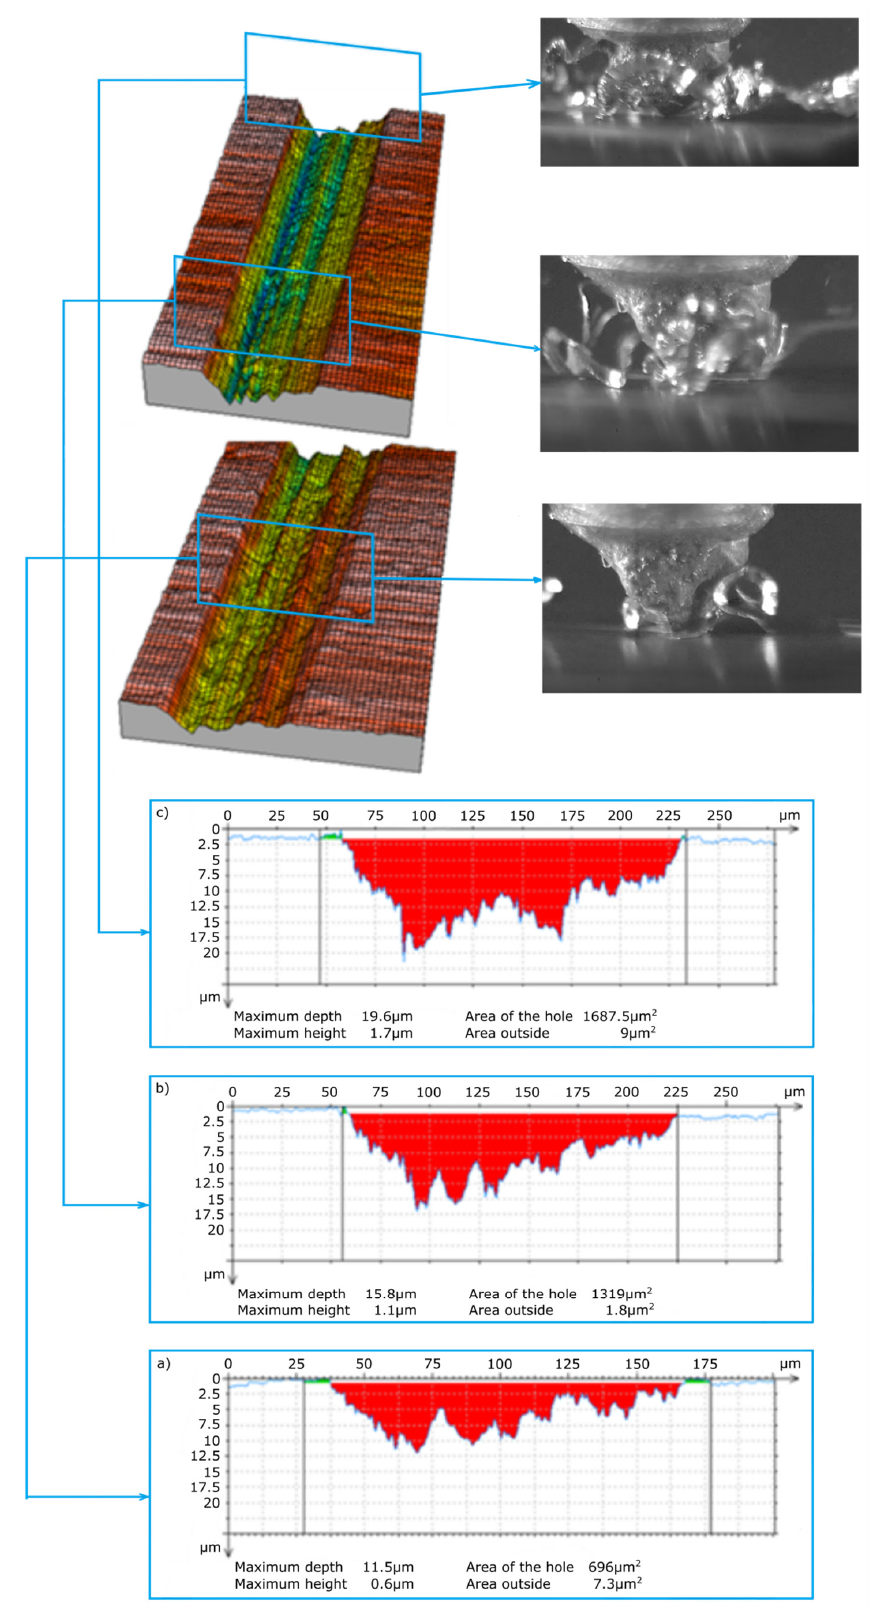
Figure 7. View of the scratch formed by the ZS1 abrasive grain and cross-sections of the scratch for depths of cut of ( a ) 10 µm, ( b ) 15 µm and ( c ) 20 µm.